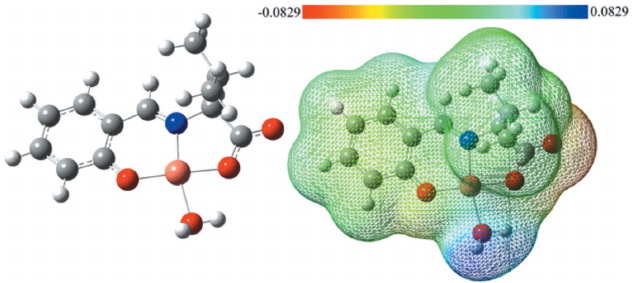
Figure 5 Optimized structure and electrostatic potential map for the title